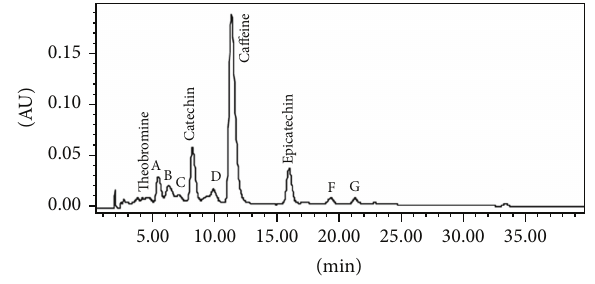
Figure 1: HPLC chromatograms of polyphenols and alkaloids in Cola acuminata seeds. Separation of polyphenols was performed on a LiChroCART 250-4 octadecylsilyl (ODS) C18, 5 𝜇 m particle (RP- 18 (5 𝜇 m)) column (Merck) at 26 ∘ C. The guard column consisted of a LiChroCART 4-4 LiChrospher 100RP-18 (5 𝜇 m) (Merck). The binary mobile phase consisted of 2% acetic acid in water (A) and acetonitrile-water-concentrated acetic acid mixture (4: 9: 1v/v/v) (B). Letters or numbers over the peak indicate unidentified polyphe- nolic compounds. (Source: